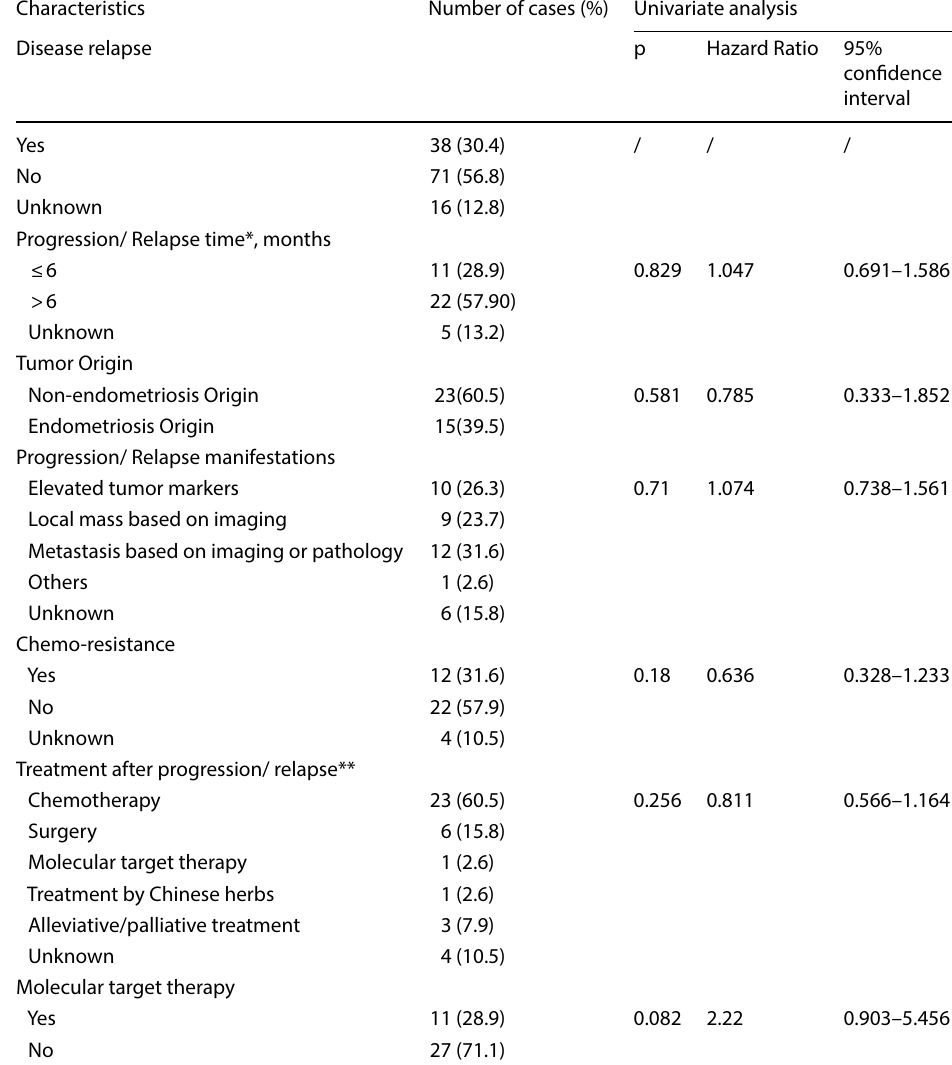
Table 3 Relapsed patients’ characteristics and Univariate analyses of impact of various relapse-related prognostic parameters on overall